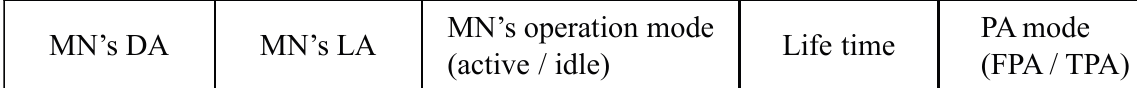
Figure 5. SIP MA’s data structure for